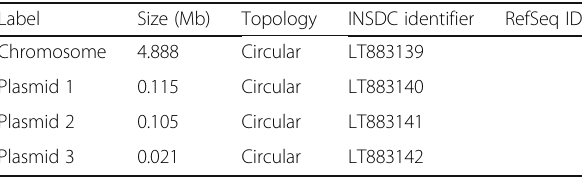
Table 3 Summary of 1094 genome: one chromosome and 3 putative